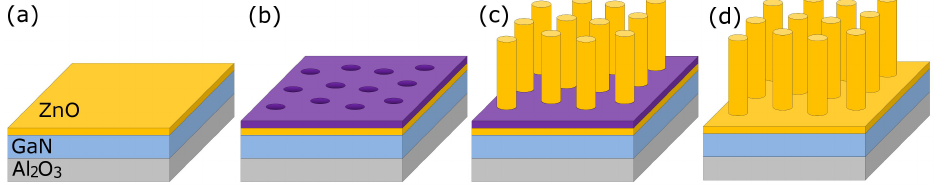
Figure 1. Schematic process flow of ZnO nanowire arrays. The processing steps were as follows: Deposition of epitaxial ZnO layer on GaN template using ALD ( a ), Pattern generation in PMMA by e-beam lithography ( b ), Wet epitaxial growth ( c ), and PMMA removal in acetone ( d ).